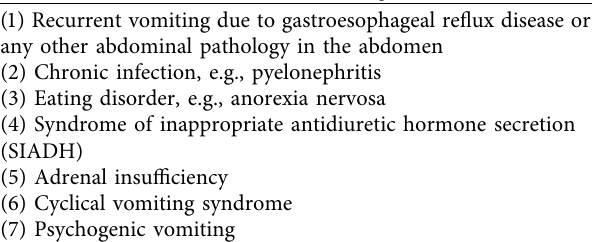
Figure 1: MRI of this patient showing lobular tumor occupying sellar and suprasellar region measuring 2.4 cm × 2.0 cm × 2.0cm. Caudal part of the lesion showed intermediate signal intensity in T2-weighted images. Superior mass effect is seen on the optic chiasma, optic tract, and AI segments of bilateral anterior cerebral arteries. Mass is bulged into the sphenoid sinuses. ((a, b)) T1-weighted, gadolinium-enhanced sagittal and coronal views. ((c, d)) T2-weighted axial and coronal views. Table 2: Differential